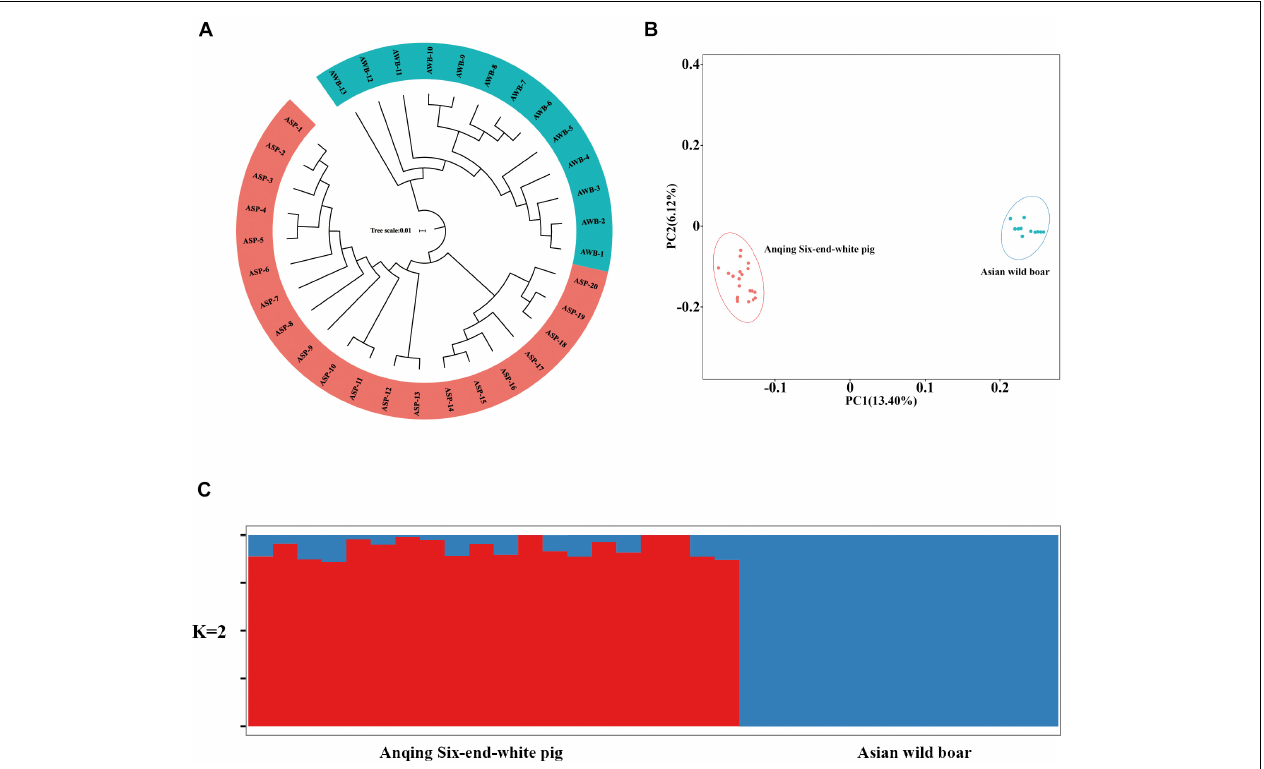
FIGURE 2 | Population structure and principle component analysis. (A) Neighbor-joining tree constructed from single nucleotide variant (SNV) data among study population. (B) Principle component plots for the first two PCs for all 33 individuals. (C) Structure analysis on all the Asian wild boars and Anqing six-end-white pigs with K = 2.